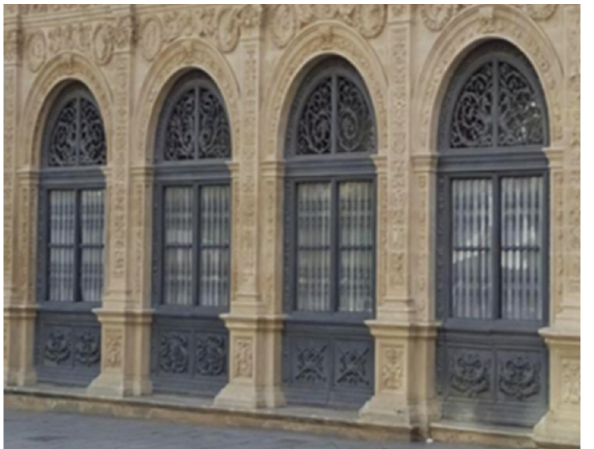
Table 8. Openness of tasks and breakdown for each trail.